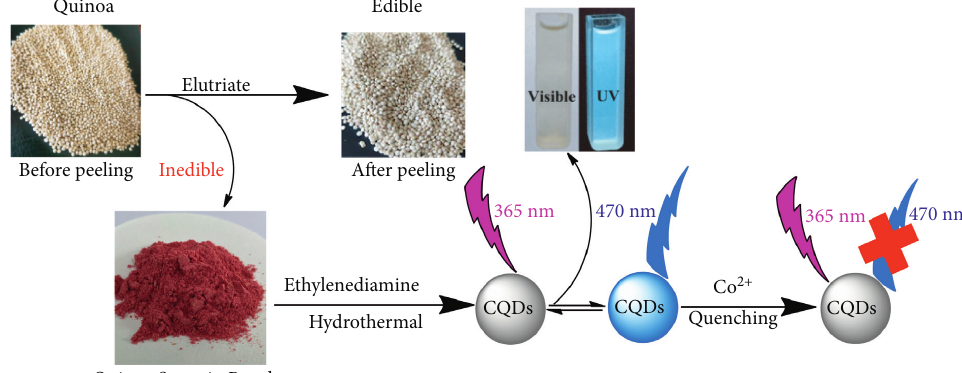
Figure 1: Schematic illustration of synthesis route and application for Co 2+